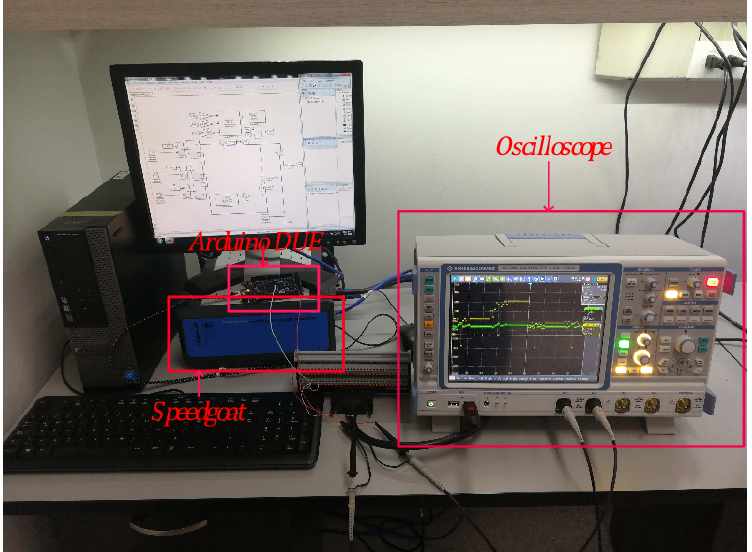
Figure 12. Experimental setup of a Speedgoat and an arduino in hardware in the loop validating the results in an oscilloscope.